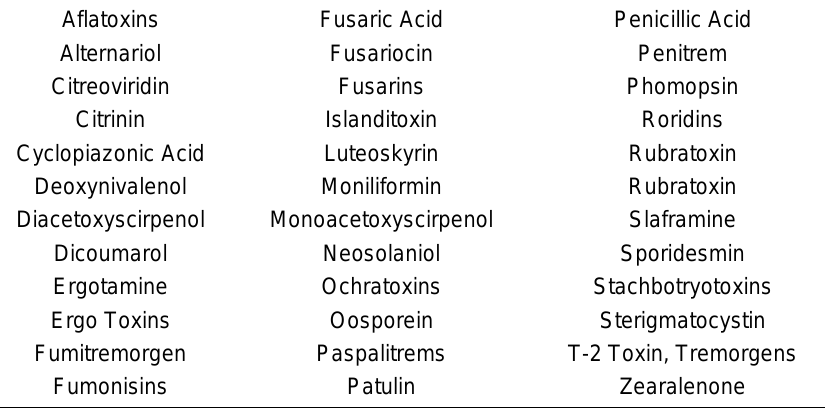
A List of Some of the Known